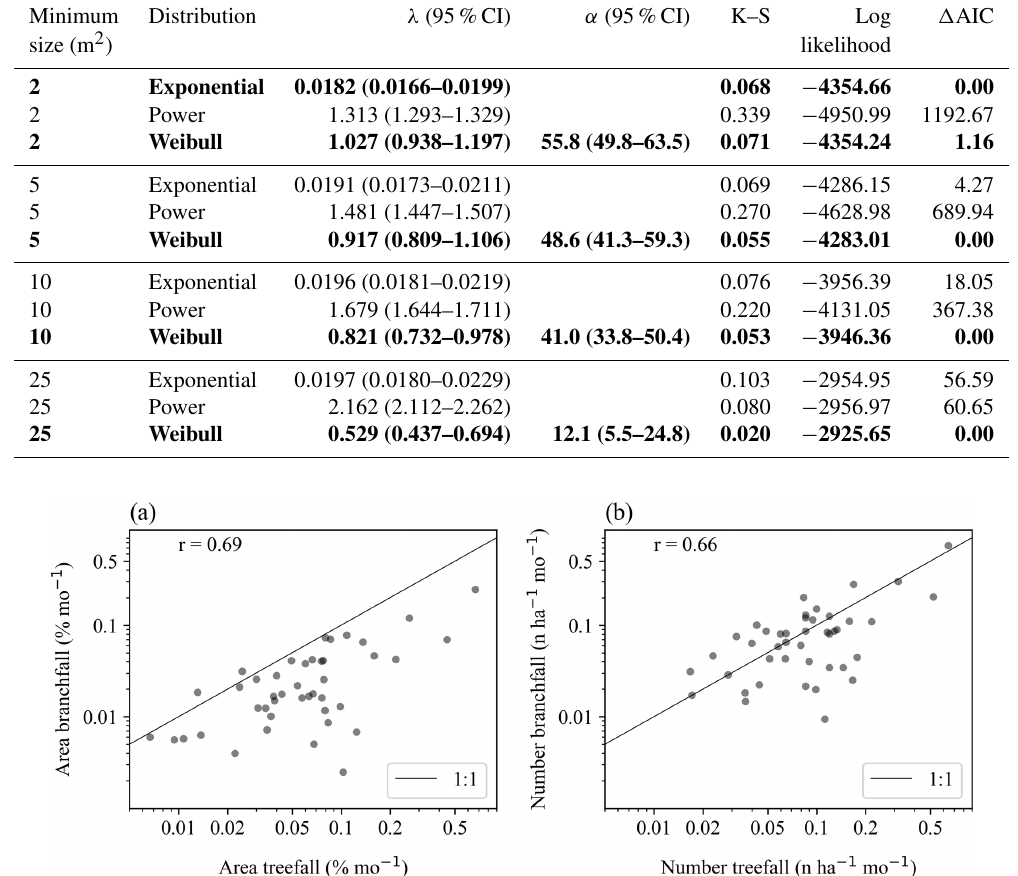
Table 1. Parameter values, Kolmogorov–Smirnov (K–S) statistics, the log-likelihood function, and (cid:49) AIC values for maximum-likelihood fits of exponential, power, and Weibull probability density functions to size distributions for canopy disturbances larger than 2, 5, 10, and 25m 2 . (cid:49) AIC is the difference in AIC from the best model. The best-fit models for each dataset, as well as those within 2 (cid:49) AIC of the best model, are highlighted in bold.